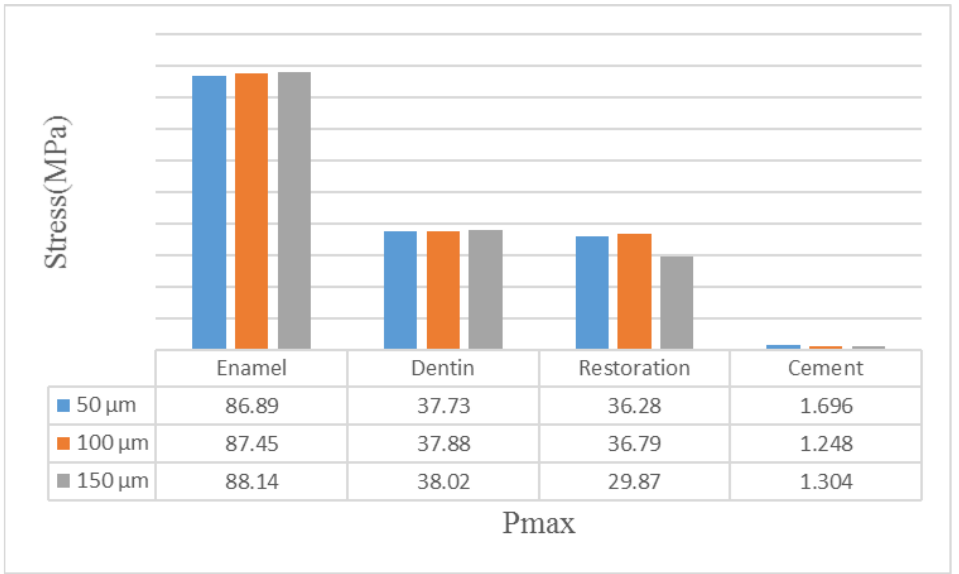
Figure 8. Maximum principal stress distribution in restorations applied with RC of different thick- nesses (50 GPa Young’s modulus of amalgam).